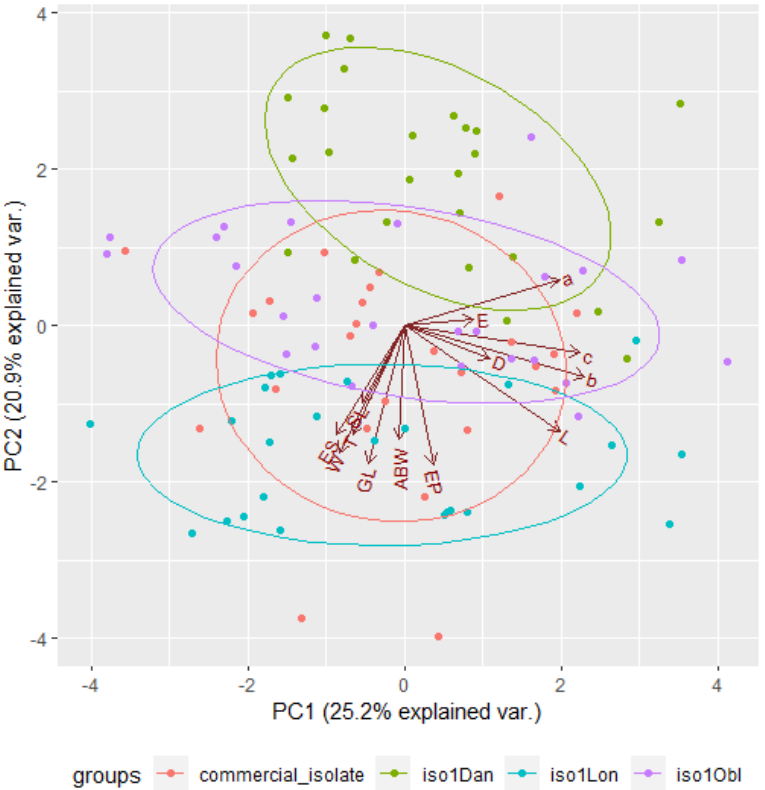
Figure 6. Principal component analysis for first ‐ stage adult males—individuals.